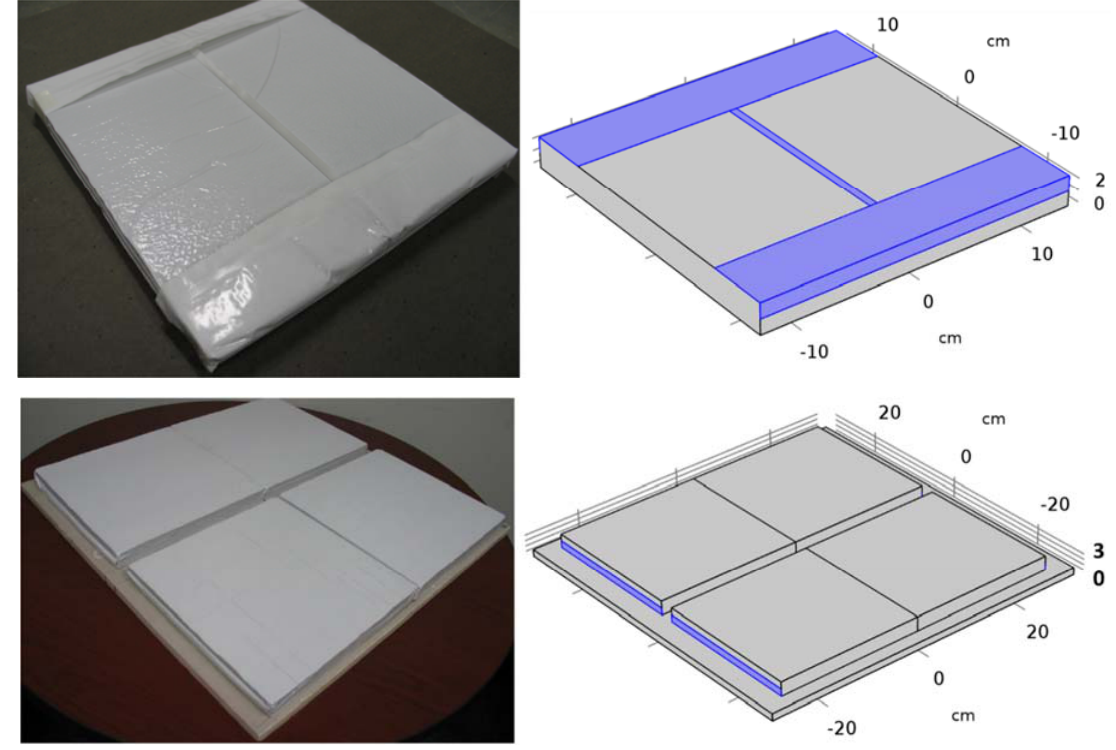
Figure 5. Illustration of physical and modeled VIP ( top row ) and VIP ‐ HD board composite ‘d’ ( bottom row ).